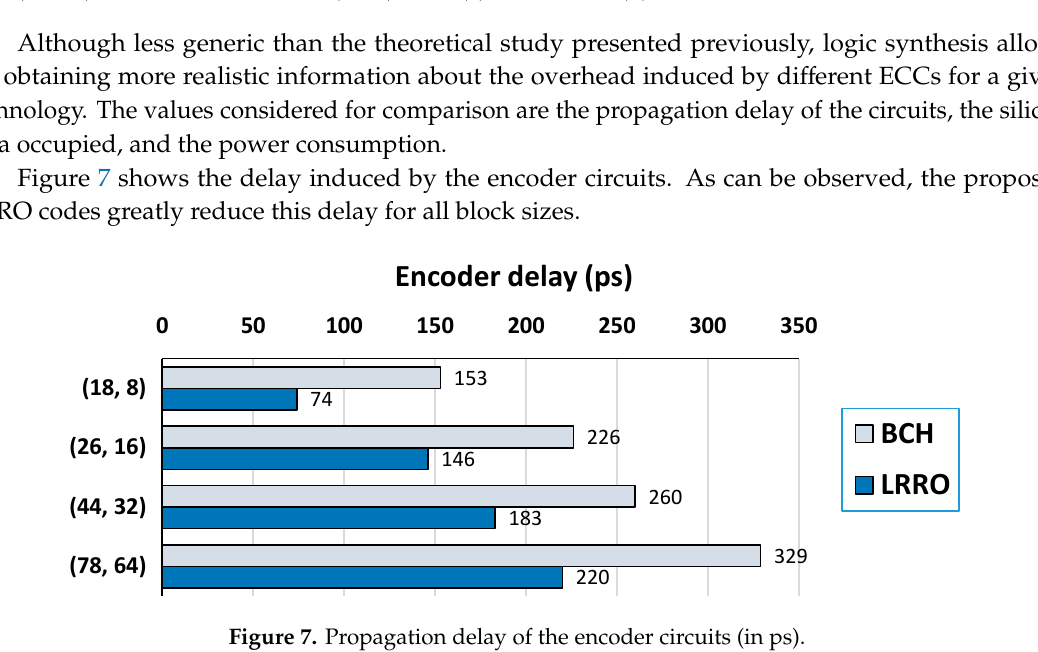
Figure 8. Propagation delay of the decoder circuits (in ps). Figure 9. Silicon area occupied by the encoder circuits (in µm 2 ). Figure 10. Silicon area occupied by the decoder circuits (in µm 2 ).